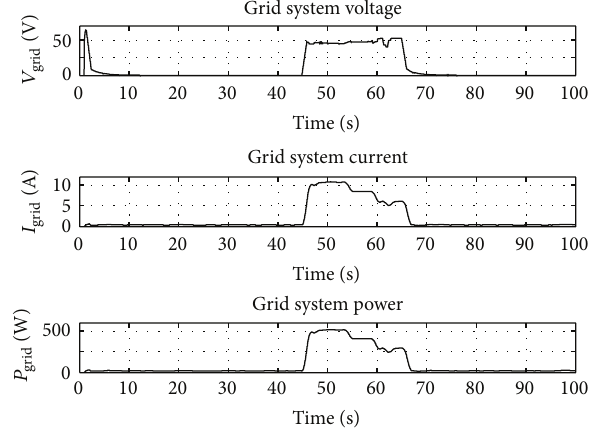
Figure 22: Variations of current, voltage, and power from the utility grid in case 2.